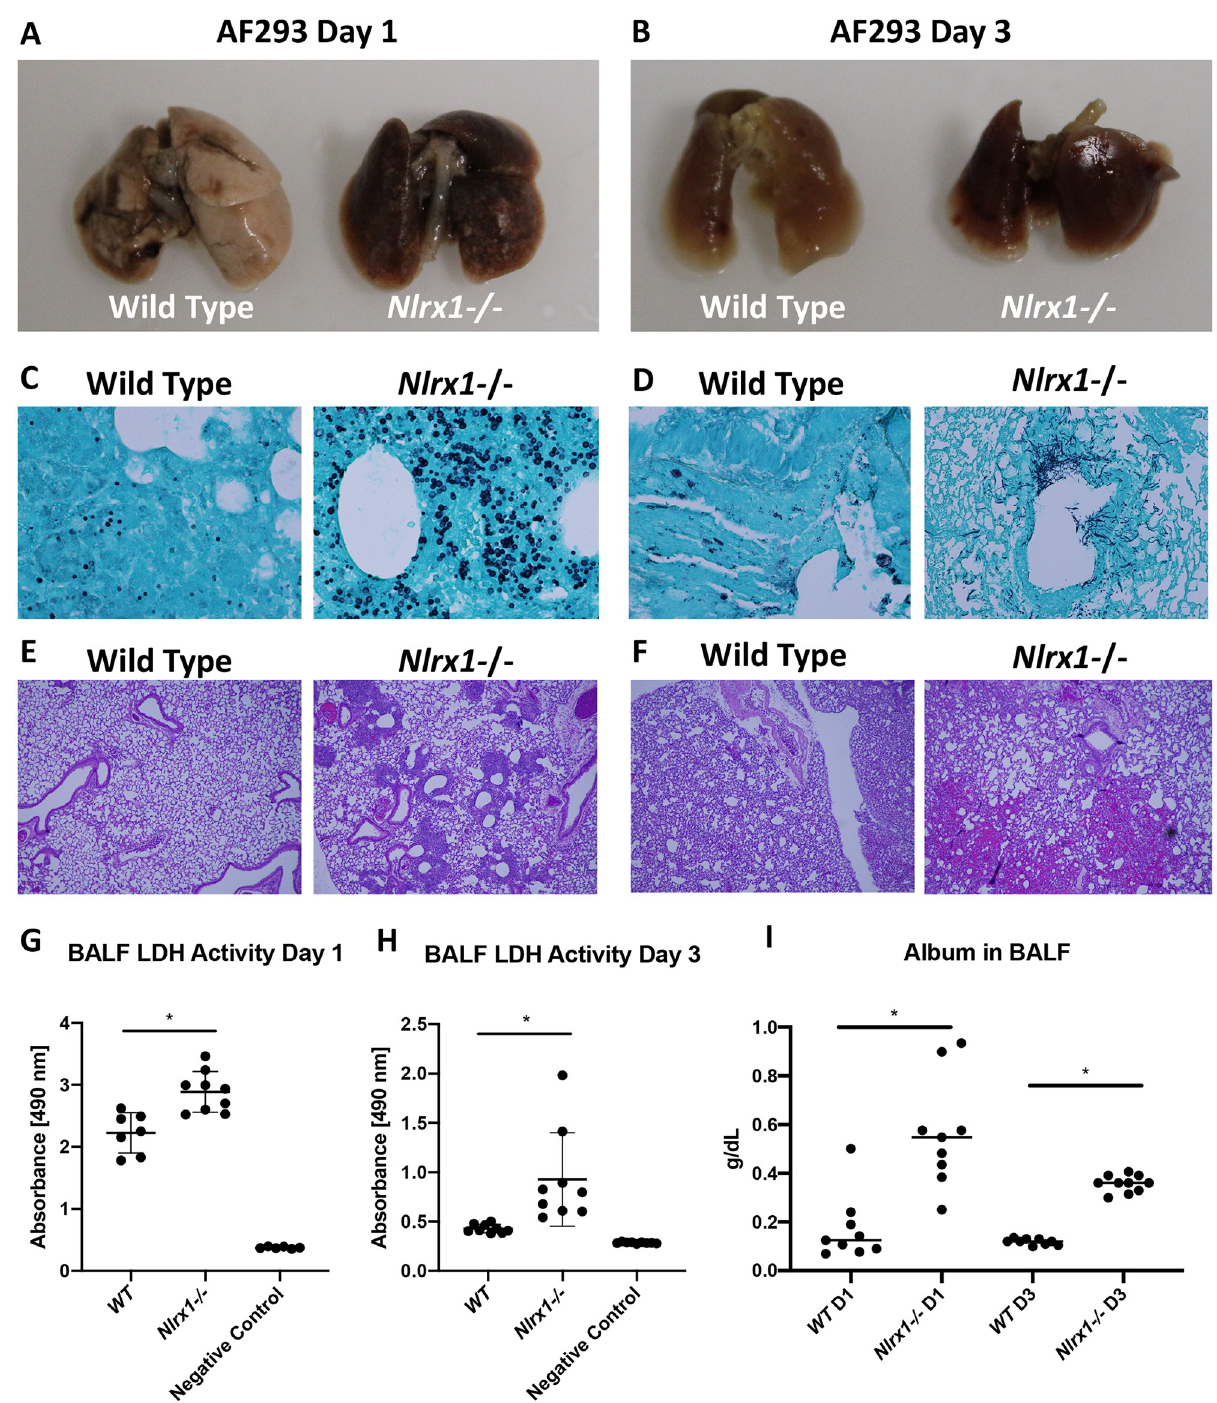
Fig 2. Characterization of pulmonary inflammation and fungal burden on day 1 and 3 post inoculation with AF293. Freshly harvested conidia from the AF293 isolate were delivered via aerosolization (12 mL, 1 X 10 9 conidia/mL) to immuno-competent wild type and Nlrx1-/- mice. (AB) Gross anatomy of excised lungs perfused with formalin on day 1 and 3 post inoculation. (CD) Grocott’s methenamine silver stain and (EF) hematoxylin and eosin stain of lung sections from wild type and Nlrx1-/- mice on day 1 and 3 post inoculation. (GH) Lactate dehydrogenase activity in bronchoalveolar lavage fluid (BALF) from wild type and Nlrx1-/- mice on day 1 and 3 post inoculation. (I) Albumin levels in BALF from wild type and Nlrx1-/- mice on day 1 and 3 post inoculation. Asterisk denotes statistical significance, P < 0.05, Mann-Whitney U test. Error bars indicate standard deviation. N = 6–10.